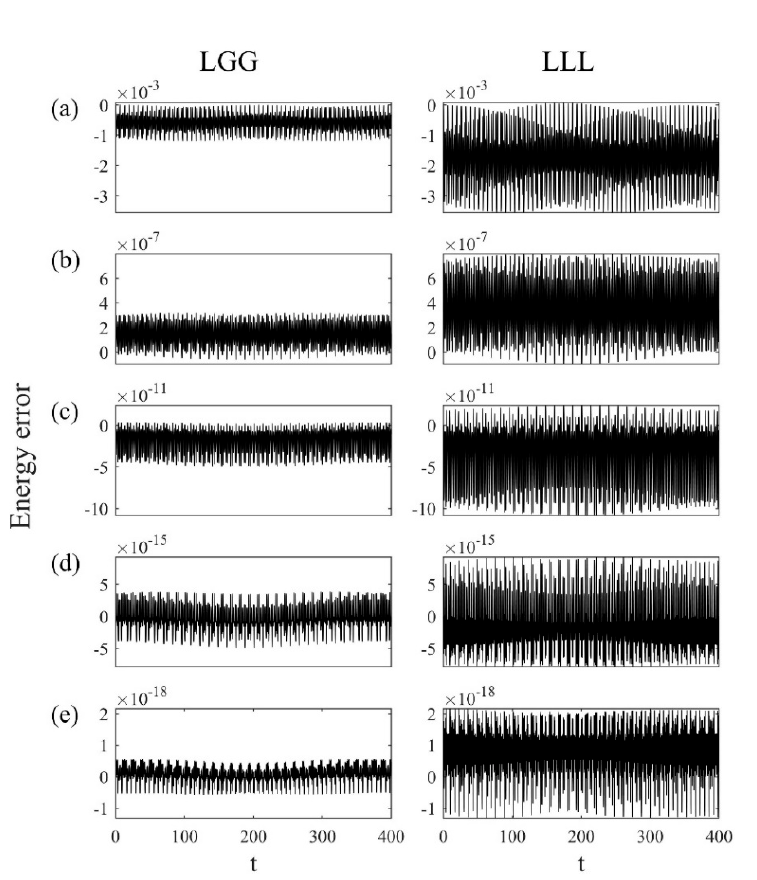
Figure 8. Six balls: Energy error of LGG and LLL with ( a – e ) corresponding to m = 2, 3, ··· , 6, respectively.